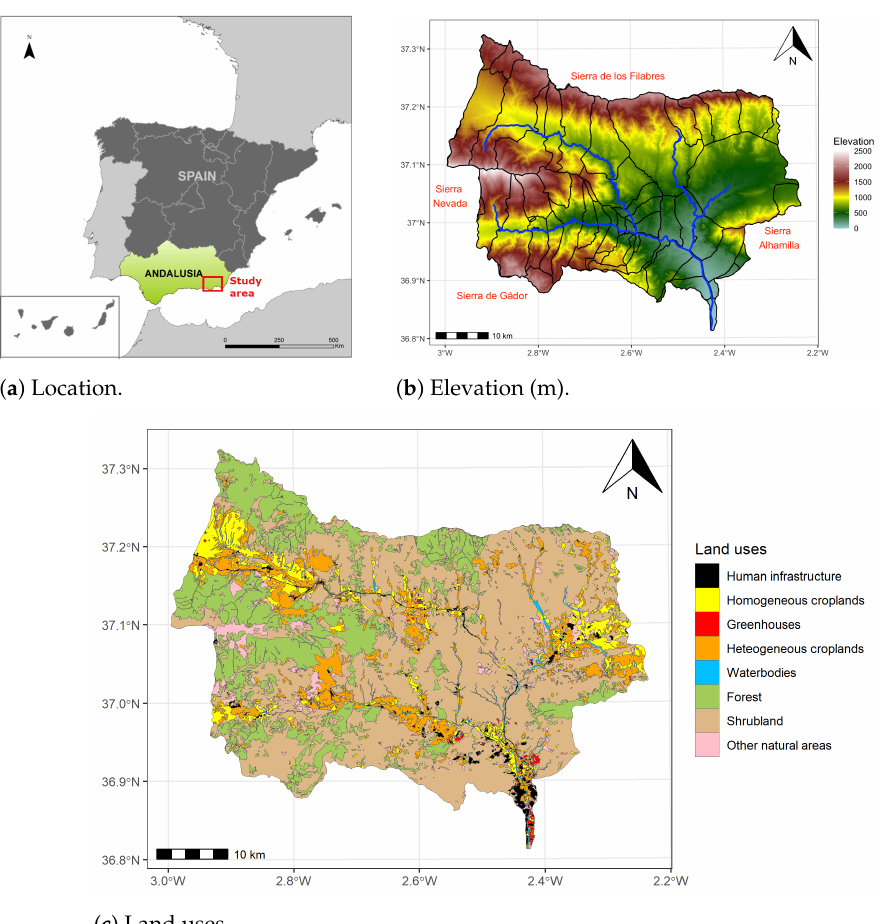
Figure 1. Geographic location ( a ); elevation above the sea level ( b ), along with the municipality limits (black) and the main river courses (blue); and land-uses ( c ) of the study